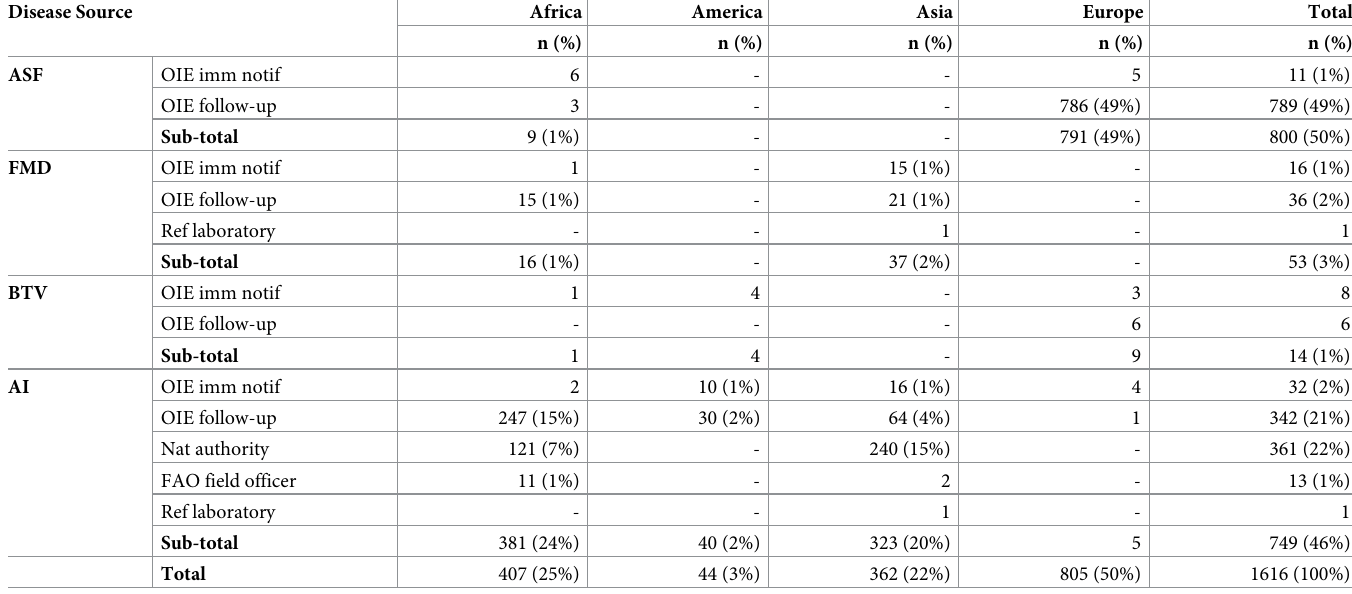
Table 2. Source and geographical distribution of confirmed outbreaks of African swine fever (ASF), foot-and-mouth disease (FMD), bluetongue (BTV) and avian influenza (AI), reported outside France, from January to June 2016. Percentages for under nine outbreaks are not shown. Disease Source